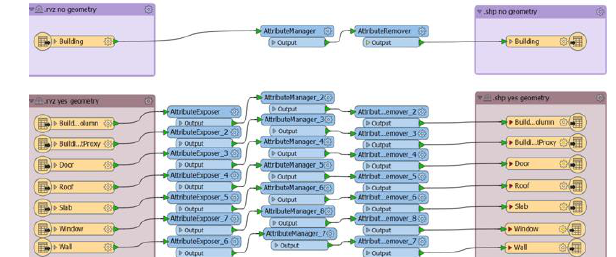
Figure 10. FME Workspace 1. From BIM to GIS: elements